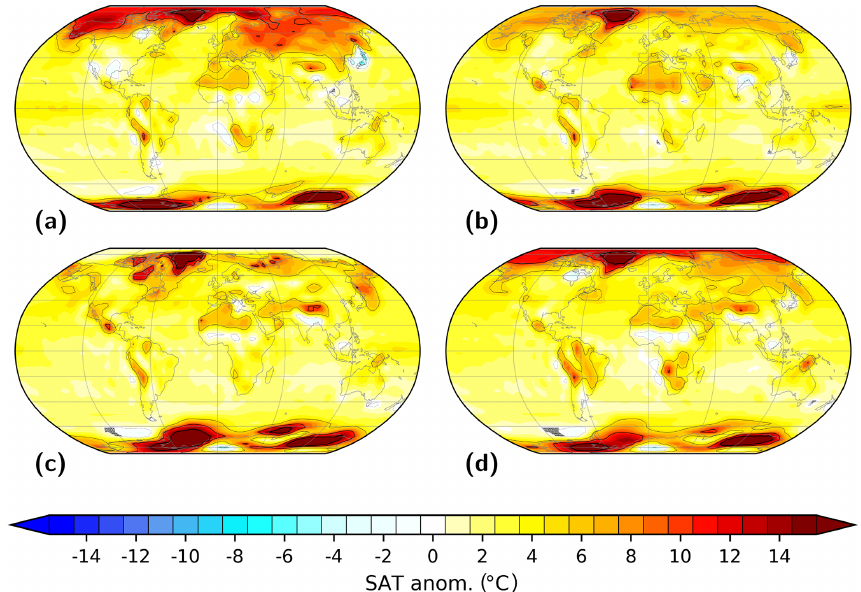
Figure 3. Seasonal mean surface air temperature (SAT) for the PlioMIP2 mid-Pliocene core simulation Eoi400. Shown are anomalies with respect to pre-industrial (simulation E280) for (a) boreal winter (DJF), (b) boreal spring (MAM), (c) boreal summer (JJA), and (d) boreal autumn (SON). Contours illustrate isotherms of − 5 ◦ C (dashed, thin), 0 ◦ C (dotted, thin), 5 ◦ C (solid, thin), 10 ◦ C (solid), and 15 ◦ C (solid, thick). In hatched regions the anomaly is insignificant at the 95% confidence interval based on a t test. We define SAT as the temperature at a height of 2m above the surface.